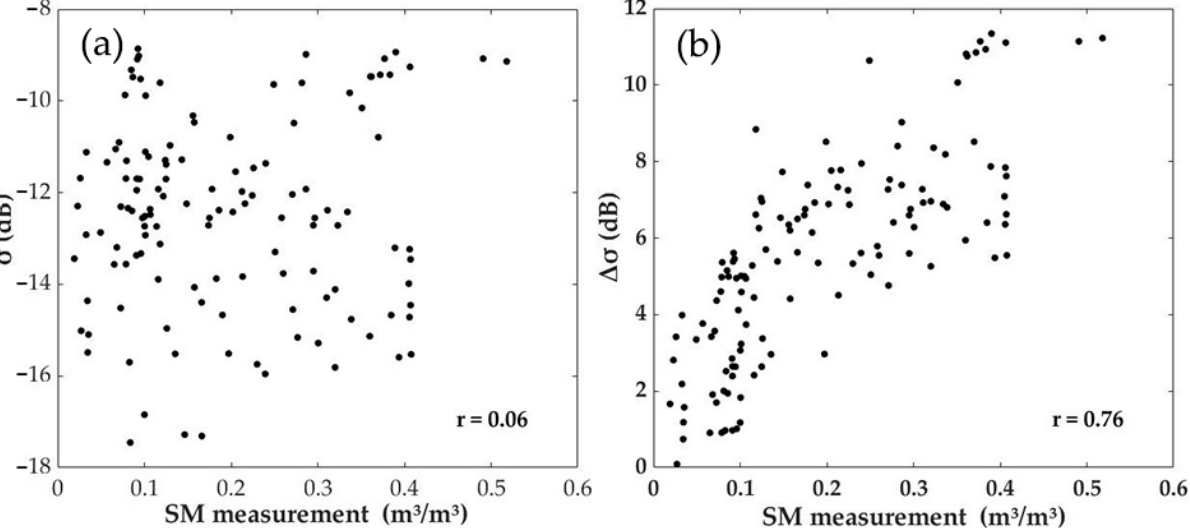
Figure 5. Relationship between the σ ° and the SM measurements. ( a ): none-corrected σ ° and SM; ( b ): Δ σ and SM.